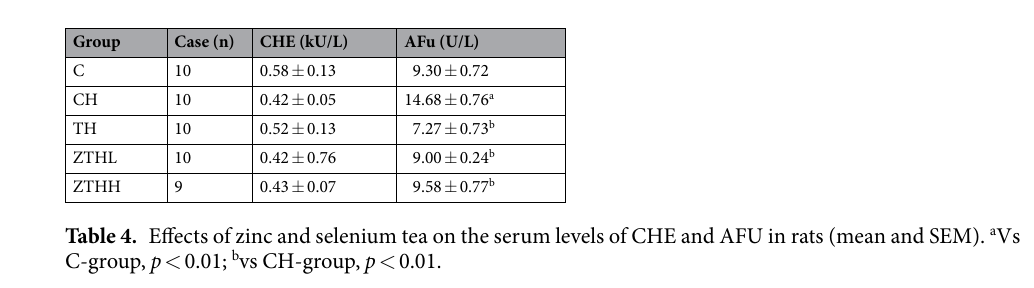
Group Case (n) CHE (kU/L)